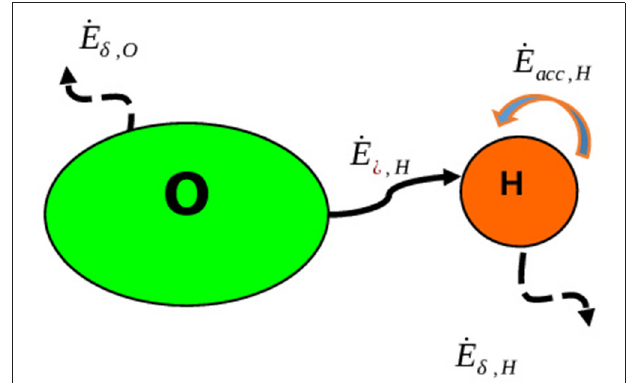
FIGURE 2 | The constant-mass open-system model with accumulation in H (growth).